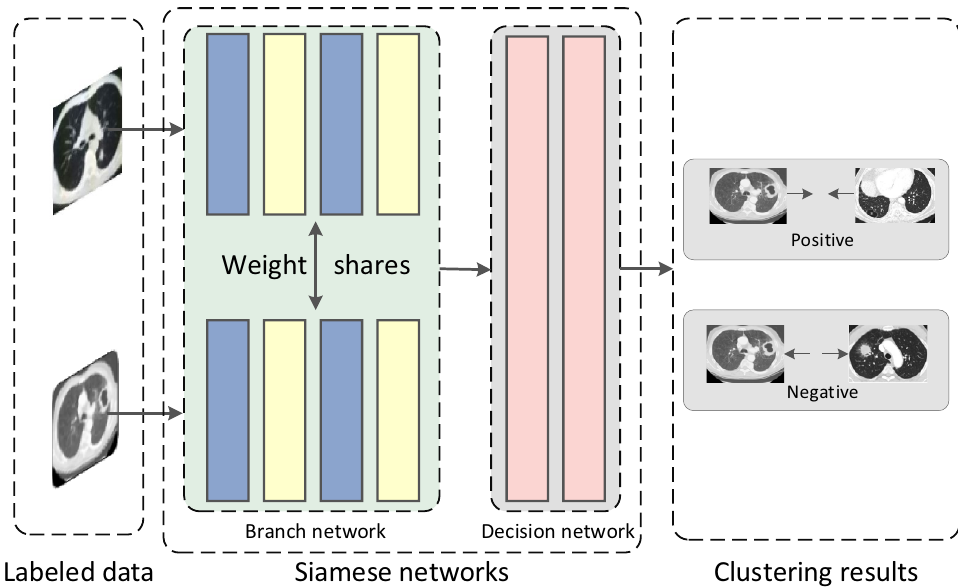
Figure 2. Weakly supervised classification model based on deep metric learning (Color code used: blue = Conv + ReLU, yellow = max pooling, pink = fully connected layer, ReLU exists between fully connected layers as well, the two branches in each stream are shared in this